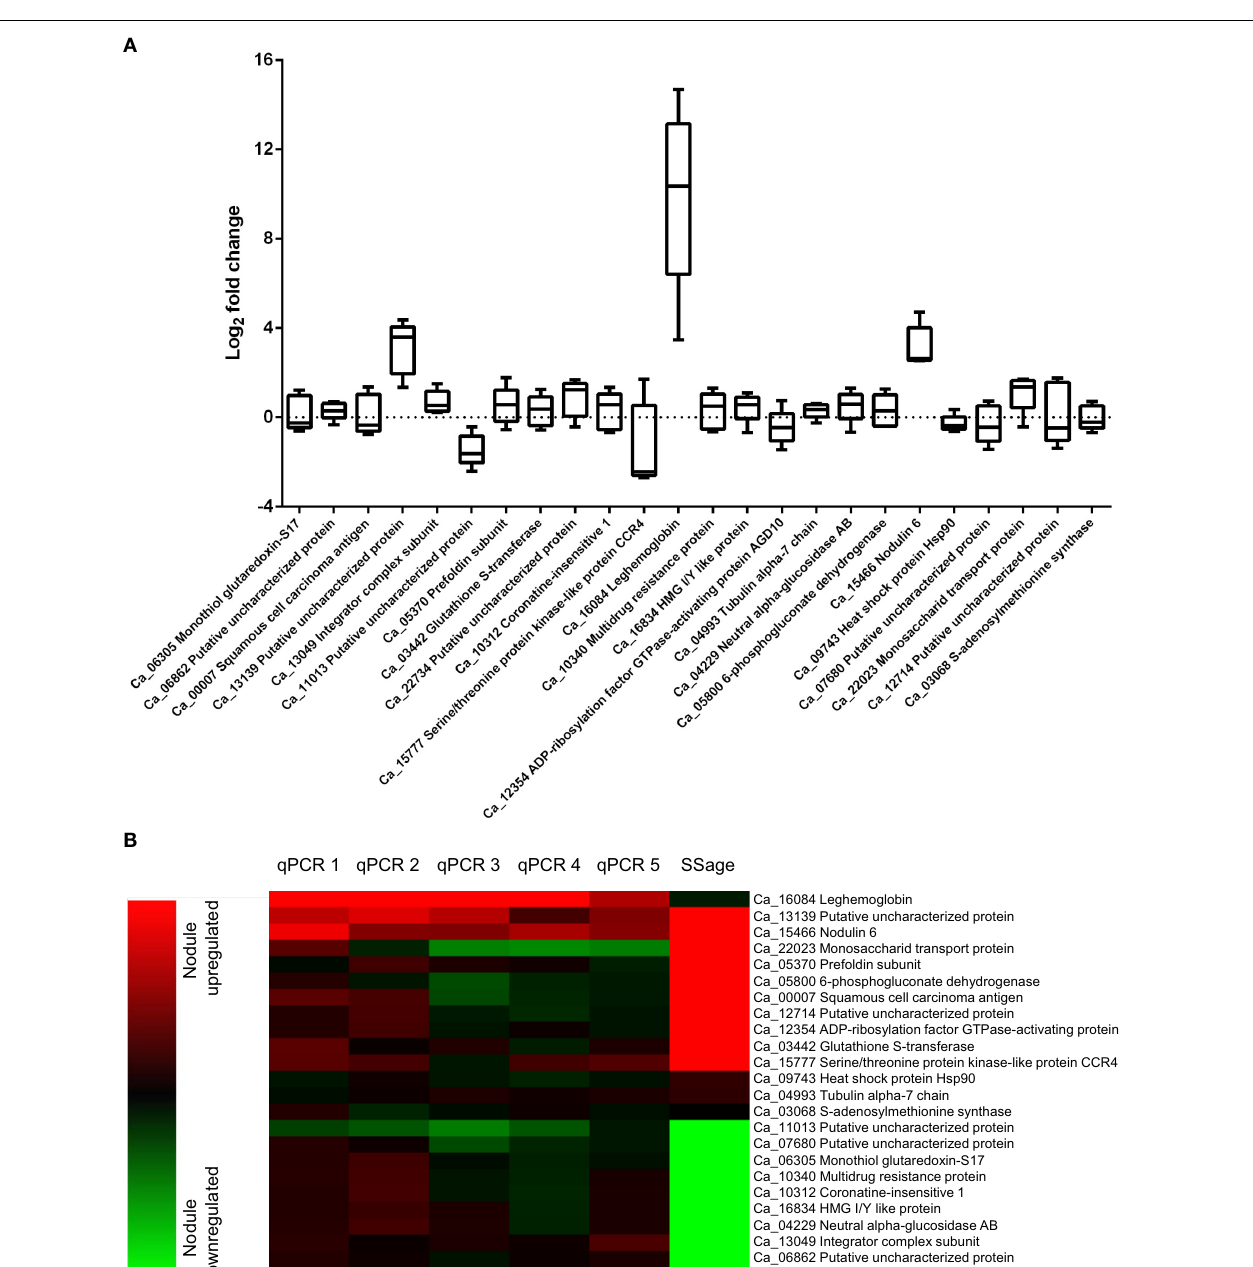
FIGURE 3 | Biological variance in gene expression of 21 candidate and three reference genes across five biological replicates (A) and comparison of deepSuperSAGE expression patterns from ten pooled plants with the individual expression ratios determined by qRT-PCR (B). The logarithmized (base 2) expression ratios between root and nodule tissue from five biological replicates are depicted in box plots for the indicated genes. Positive values represent nodule upregulated mRNAs and negative